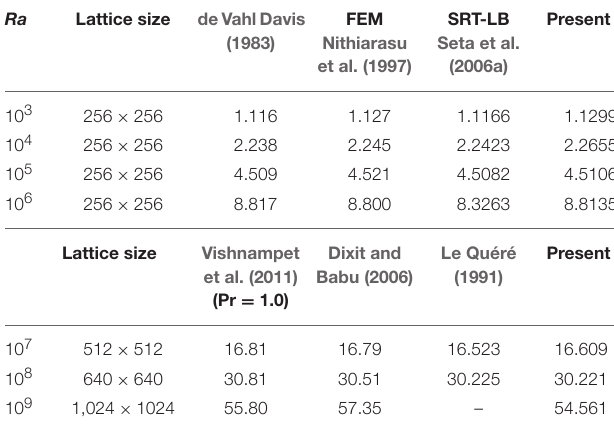
0.71, Da 10 8 , and ǫ = = =